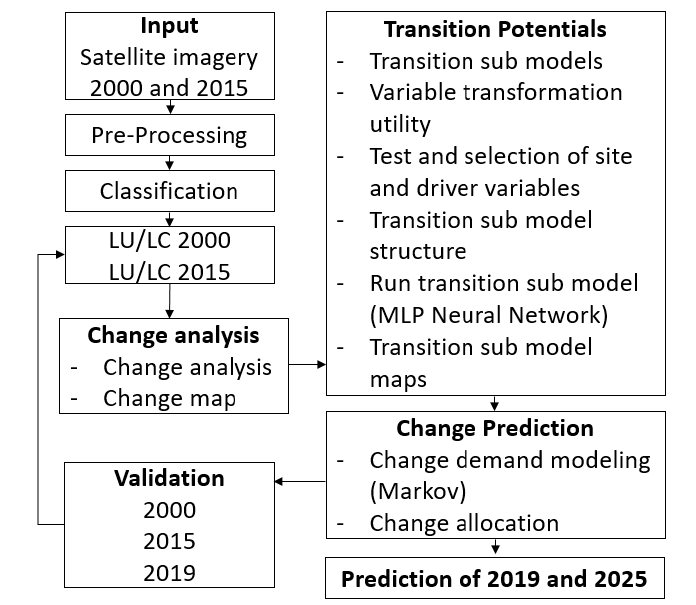
Figure 2. Flow chart of